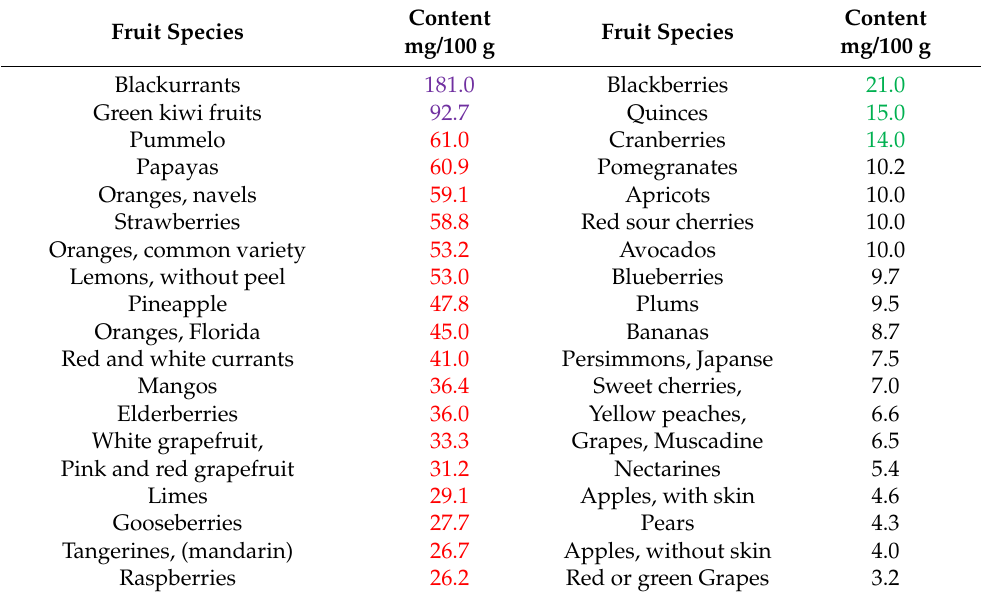
Table 1. L-Ascorbic acid content in fresh fruit [12].